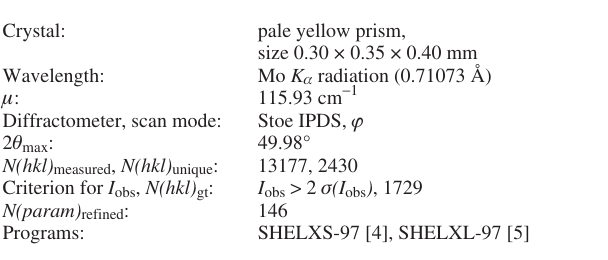
Table 1. Data collection and handling.